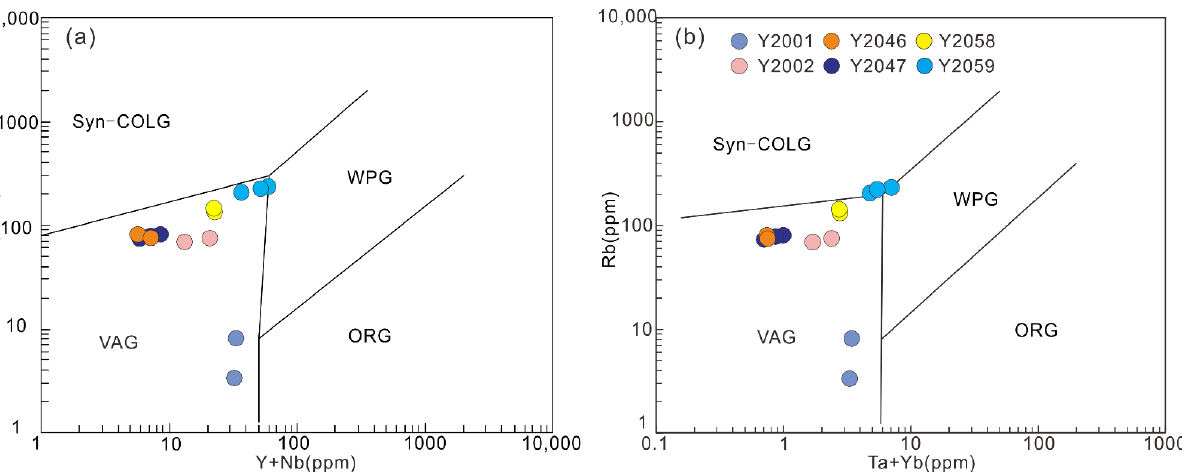
Figure 12. Tectonic discrimination diagrams of (Y + Nb)-Rb ( a ); (Ta + Yb)-Rb ( b ) for the analyzed samples (after [74]). Syn-COLG: syn-collision granites; ORG: Ocean ridge granites; VAG: volcanic arc granites; WPG: within-plate granites. The data source is the same as for Figure 7.